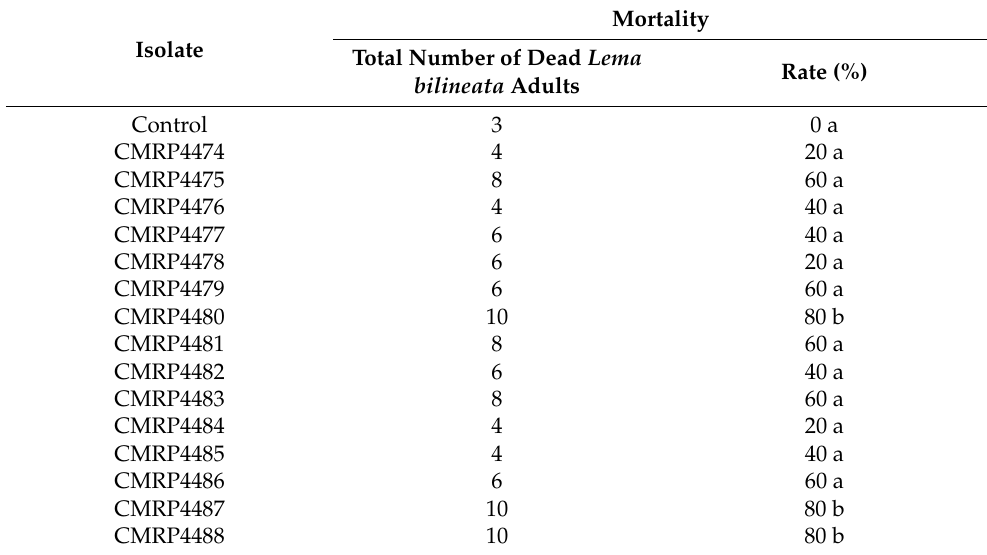
Table 2. Total number of Lema bilineata Germar (Coleoptera: Chrysomelidae) adults dead and adjusted mortality rate after inoculation with conidial suspensions (10 8 conidia mL − 1 ) of isolated Beauveria bassiana